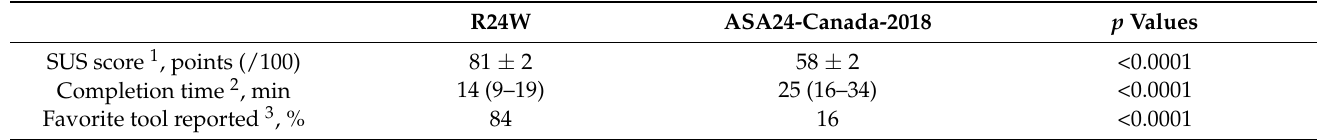
Table 3. Usability of the R24W and ASA24-Canada-2018.